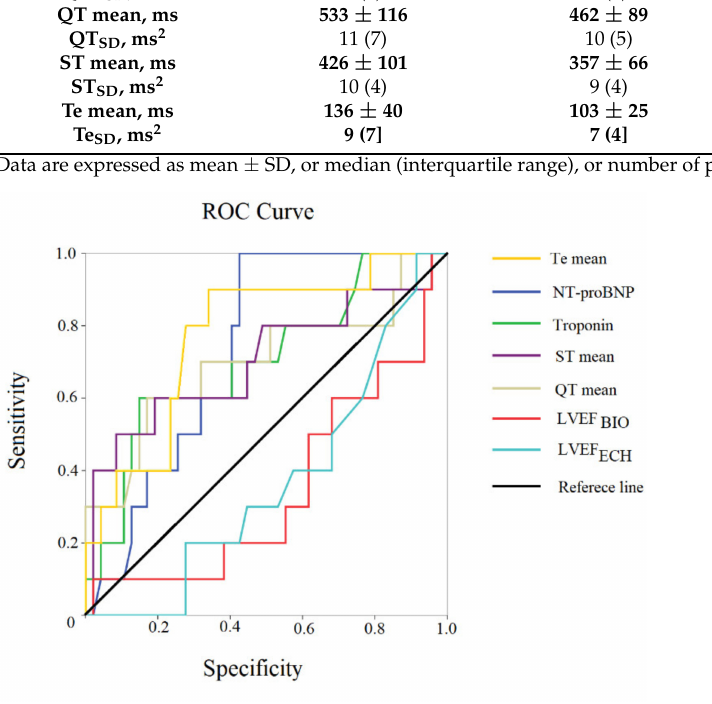
Figure 7. ROC curve of statistically significant examined variables. Sensitivity–specificity of different